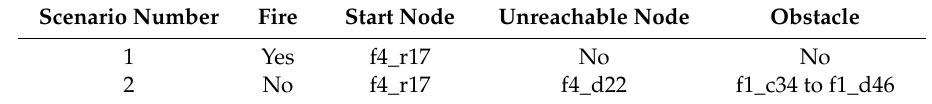
Table 5. Environmental semantics of experiment 1.